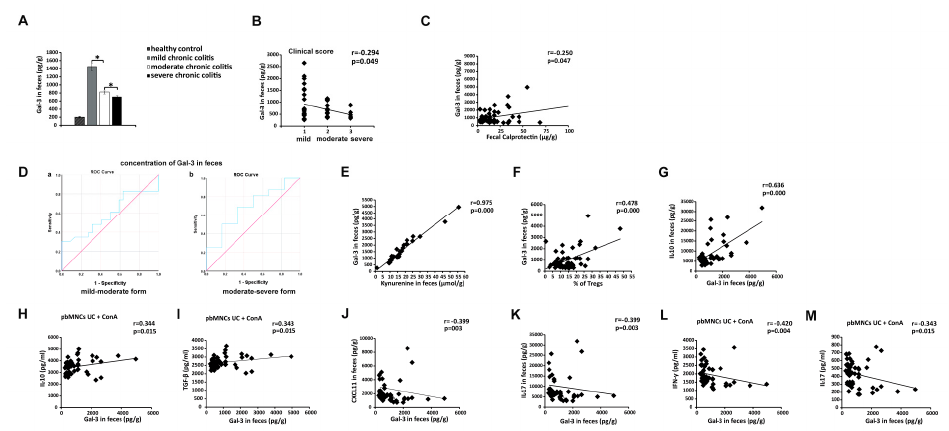
Figure 9. Fecal Gal-3 as biomarker for monitoring the progression of UC. Fecal concentration of Gal-3 ( A ). Correlation between fecal levels of Gal-3 and clinical score ( B ) and fecal calprotectin ( C ). ROC curve illustrating the specificity and sensitivity of Gal-3 fecal concentration, comparing mild chronic colitis with moderate chronic colitis (left panel) and specificity and sensitivity of fecal Gal-3, comparing moderate chronic colitis with severe chronic colitis (right panel) ( D ). Correlation between fecal concentration of Gal-3 and KYN ( E ), percentage of colon-infiltrated Tregs ( F ), fecal levels of IL-10 ( G ). Correlation between fecal level of Gal-3 and concentration of IL-10 ( H ) and TGF- β ( I ) in supernatants of Con A-stimulated pbMNCs. Concentration between fecal levels of Gal-3 and CXCL11 ( J ) and IL-17 ( K ). Correlation between fecal level of Gal-3 and concentration of IFN- γ ( L ) and IL-17 ( M ) in supernatants of Con A-stimulated pbMNCs. Mean ± standard error of the mean; * p < 0.05.